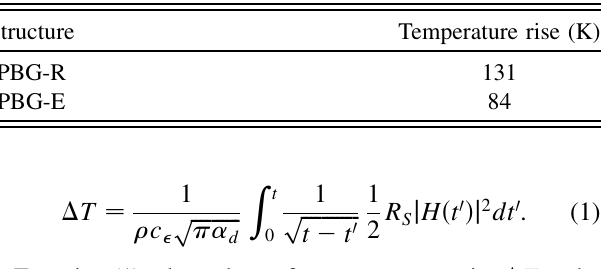
TABLE IV. Calculated peak surface temperature rise for both PBG structures at 100 MV = m accelerating